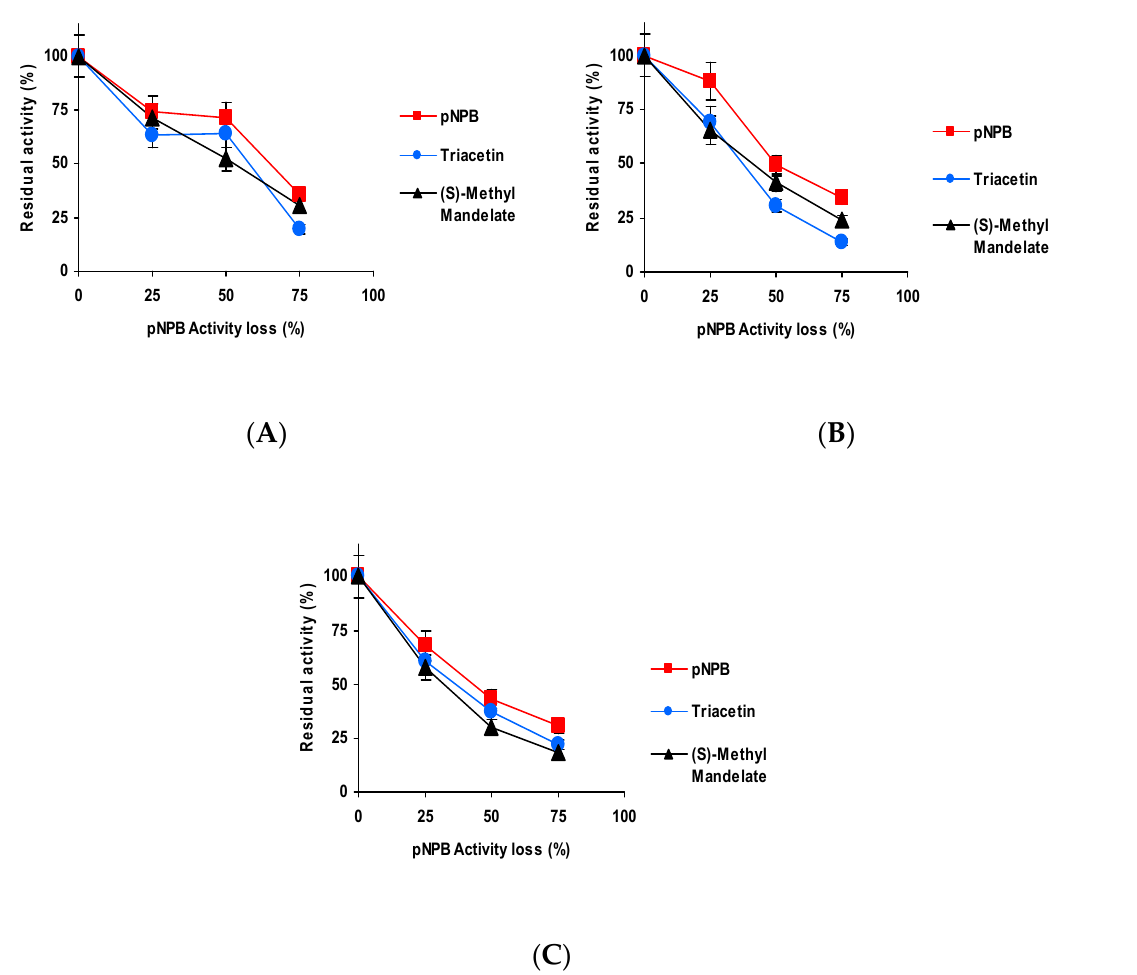
Figure 3. Effect of the inactivation pH on the residual activity versus different substrates of CALB biocatalysts activity blocked with aspartic acid. Inactivation was performed at ( A ) pH 5.0 and 80 ◦ C; ( B ) pH 7.0 and 75 ◦ C; and ( C ) pH 9.0 and 60 ◦ C. The substrates used were: p NPB; triacetin; and ( S )-methyl mandelate. Other specifications may be found in Methods section.